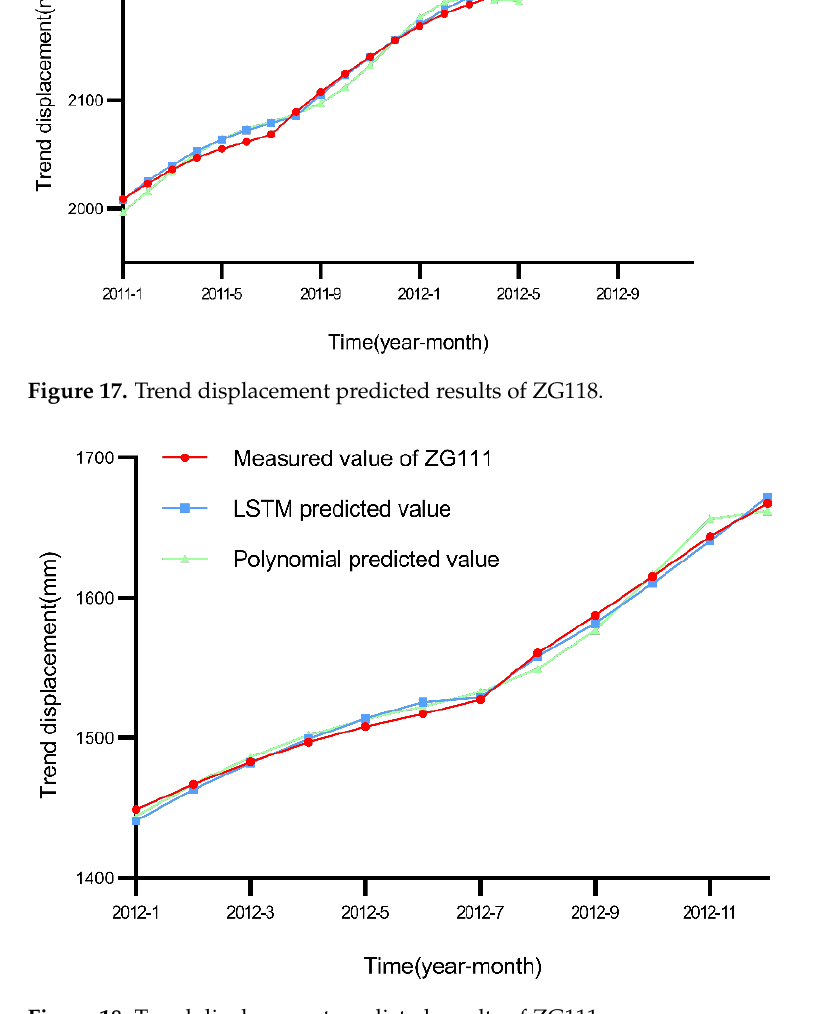
Figure 18. Trend displacement predicted results of ZG111. Table 1. Evaluation index results of each model for trend displacement